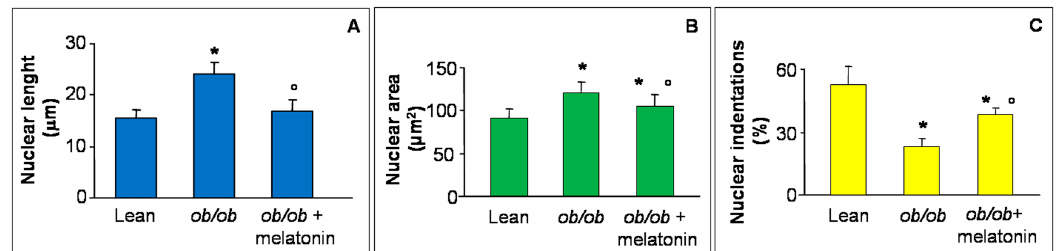
Figure 3. Nuclear features of cardiomyocytes. The graphs summarize the cardiomyocyte nuclear features analyzed: major axis length ( A ), area ( B ) and indentation ( C ) of all the experimental groups. Quantification of major nuclear axis and nuclear area indicated a strong increase of both parameters in ob / ob mice, that appeared both attenuated after melatonin treatment. Lean mice treated or not with melatonin displayed similar “normal” nuclear features of cardiomyocytes, so they are defined generically as “lean” mice. Note that nuclear indentations decreased in ob / ob mice but enhanced after melatonin intake. * p ≤ 0.05 significant vs. lean mice; ° p ≤ 0.05 significant vs. ob / ob mice.